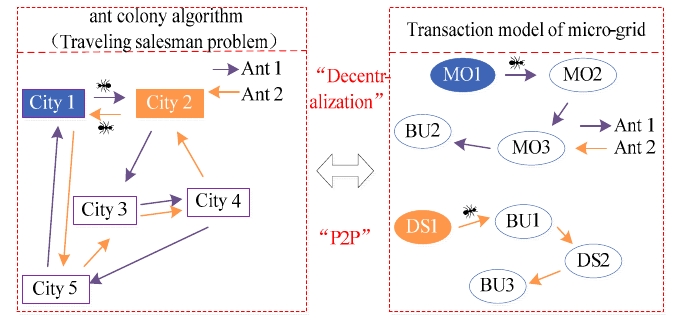
Figure 7. Analogy diagram of ant colony algorithm and microgrid group trading model.